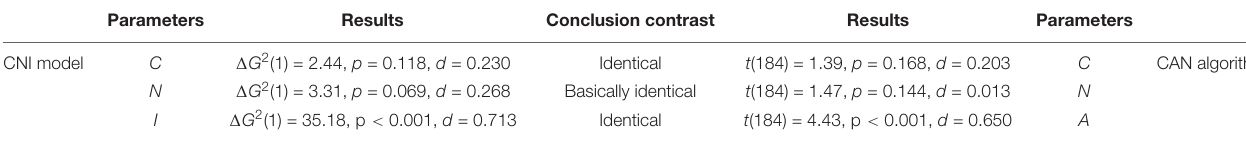
TABLE A3 | Tests of differences in question-framing with the CNI model and CAN algorithm in Study 3a by Gawronski et al. (2017). Parameters Results Conclusion contrast Results